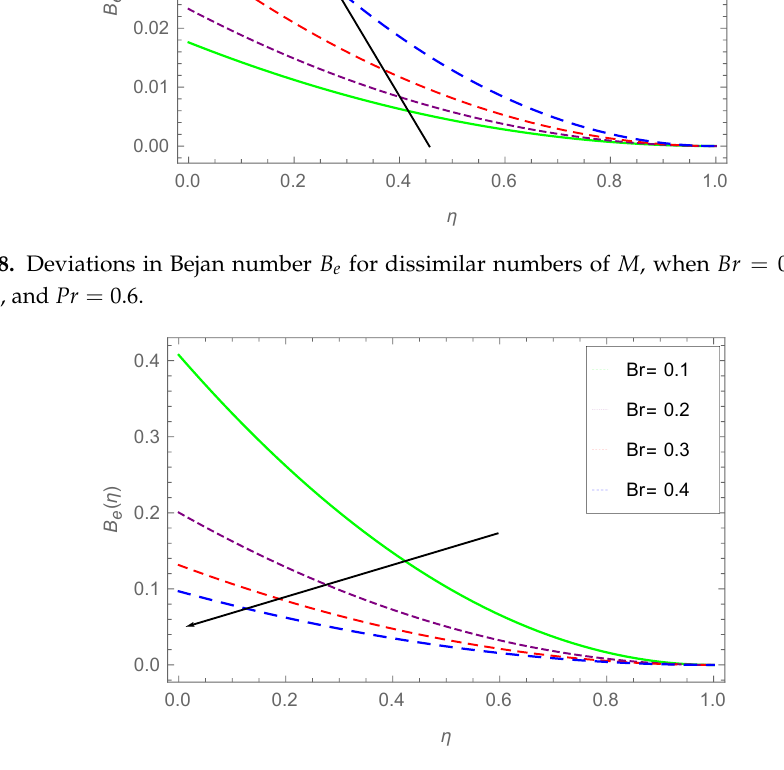
Figure 19. Variations in B e for dissimilar values of Br , when M = 0.1, R e = 0.7, Rd = 0.6, and Pr = 0.6.